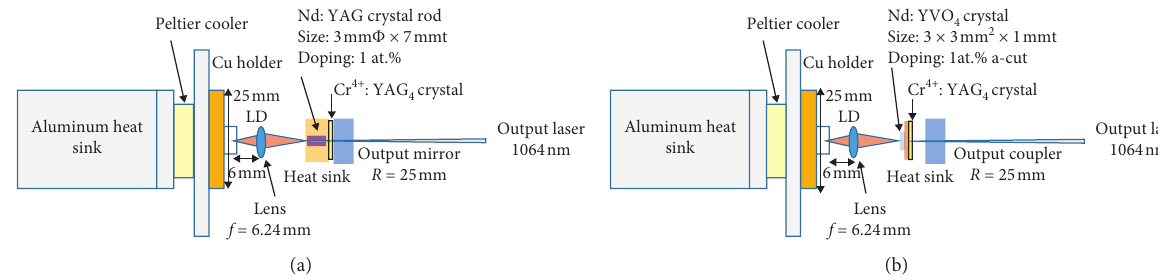
Figure 1: Experimental setup for (a) Nd:YAG and (b) Nd:YVO